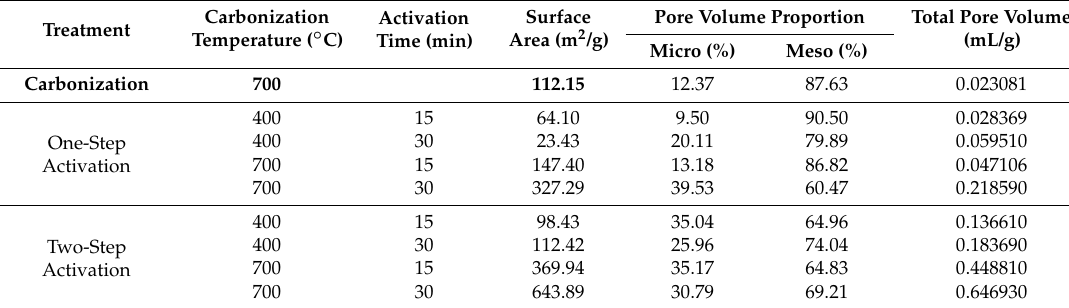
Table 3. Specific surface area of produced